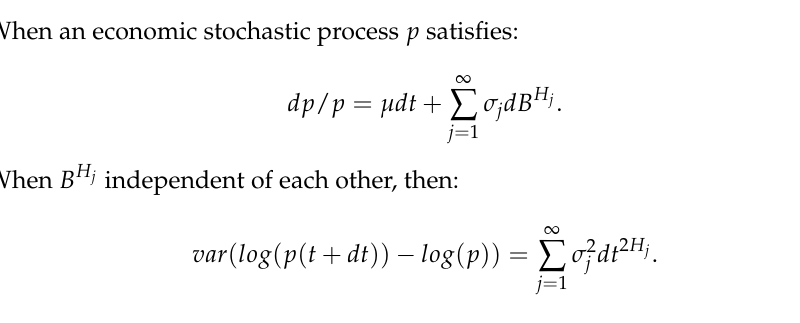
Figure 1. U. S. consumption data increases with sampling